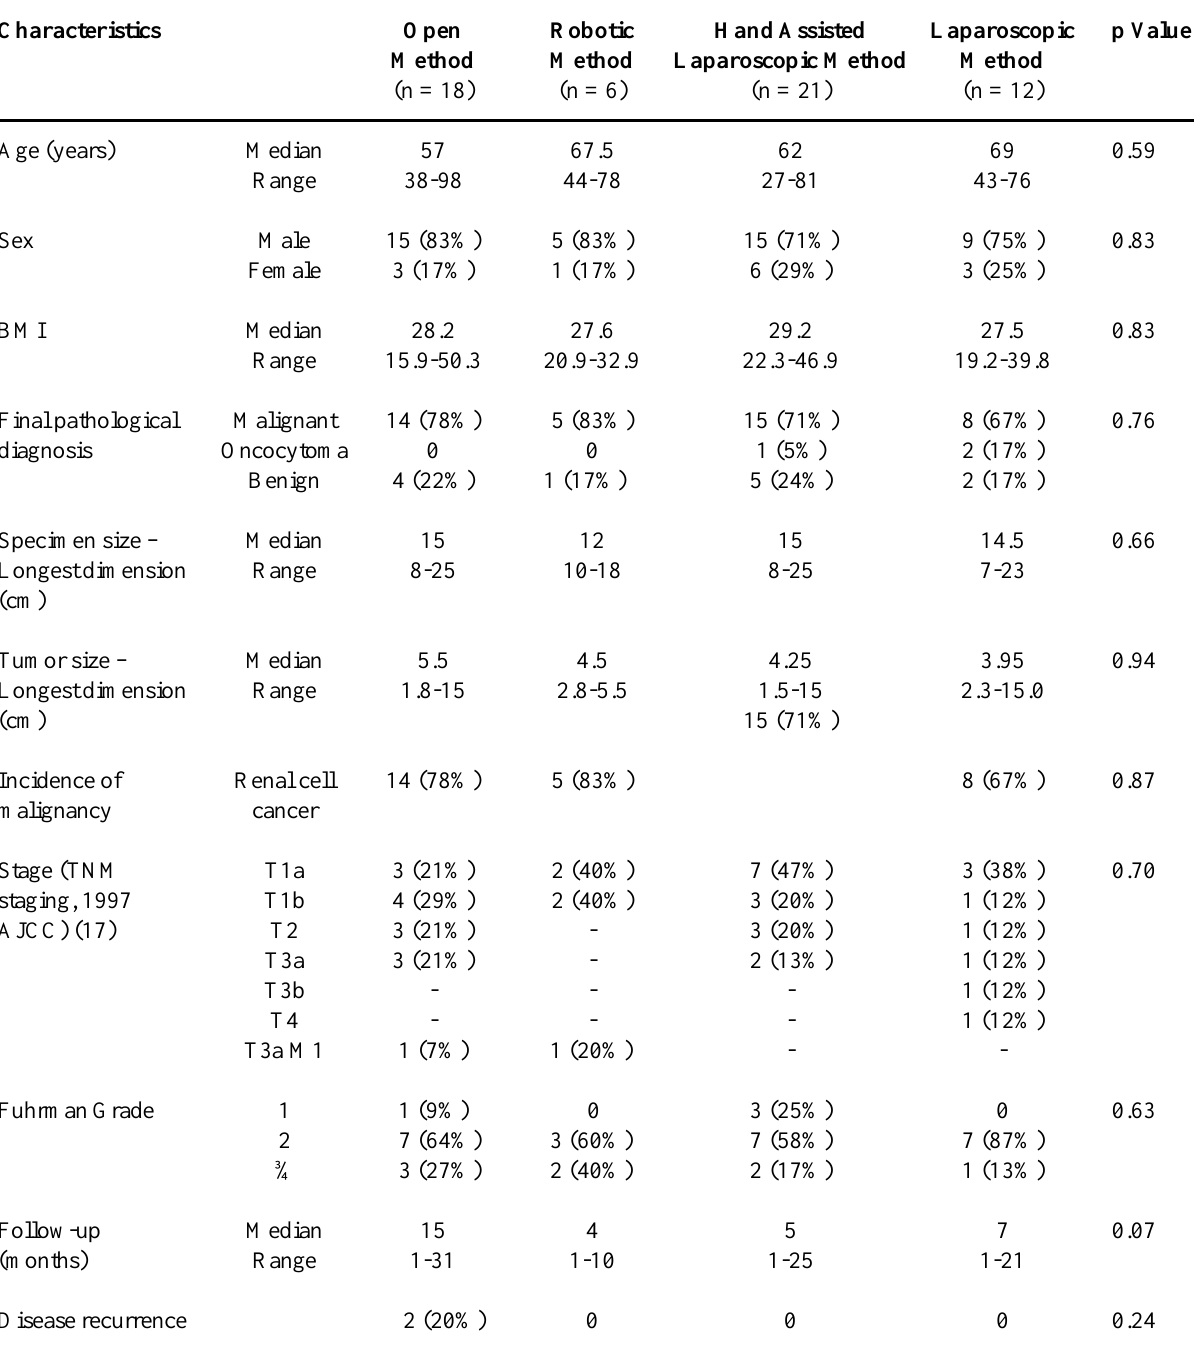
Table 1 – Comparison of characteristics of patients undergoing radical nephrectomy by different